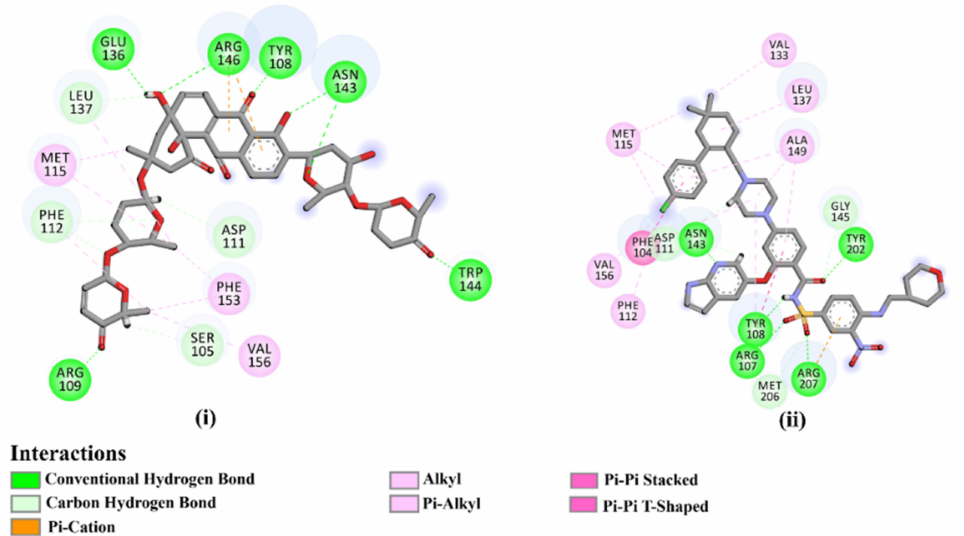
Figure 3. Two-dimensional molecular interactions of ( i ) saquayamycin F (NPA002200) and ( ii ) vene- toclax with the Bcl-2 protein according to the final snapshot over 50 ns MD simulations.